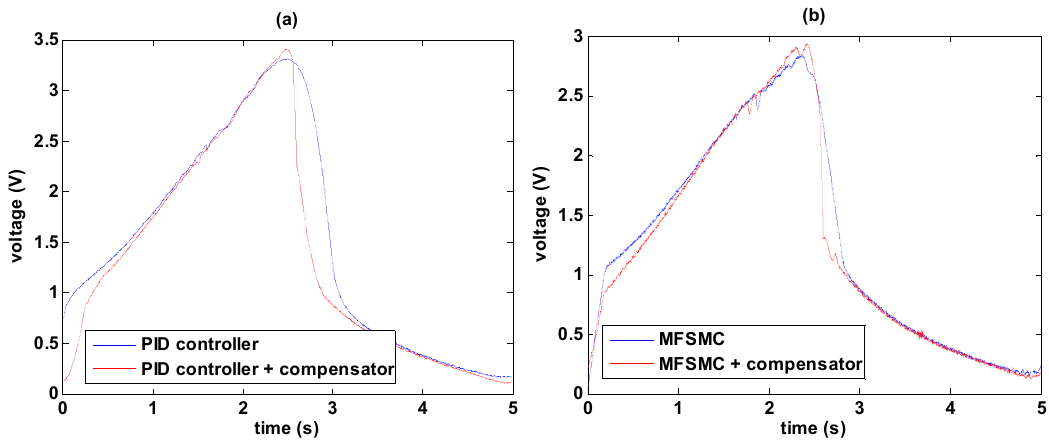
Figure 16. Control signal comparisons between using path controller solely and using path controller with the hysteresis compensator: ( a ) Using PID path controller solely and using PID path controller with the hysteresis compensator; ( b ) Using MFSMC path controller solely and using MFSMC path controller with the hysteresis compensator.